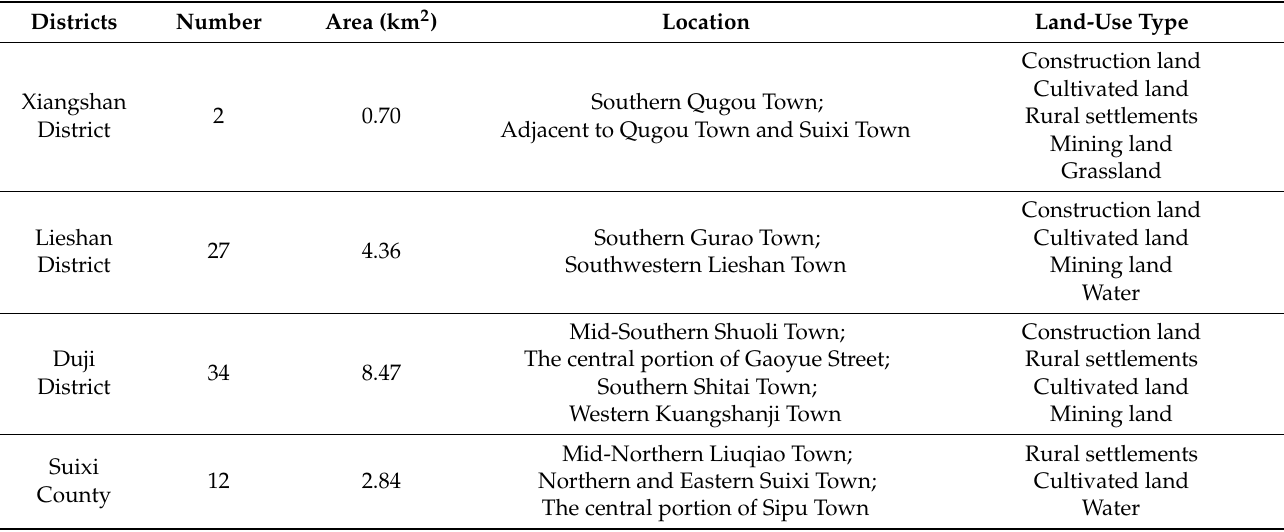
Figure 12. Ecological barrier points in Huaibei City. Red frame shows the exact location of barrier points. Subfigures( a – d ) are subfigures showing a real view of barrier points. Table 5. Distribution of ecological barrier points in Huaibei City.